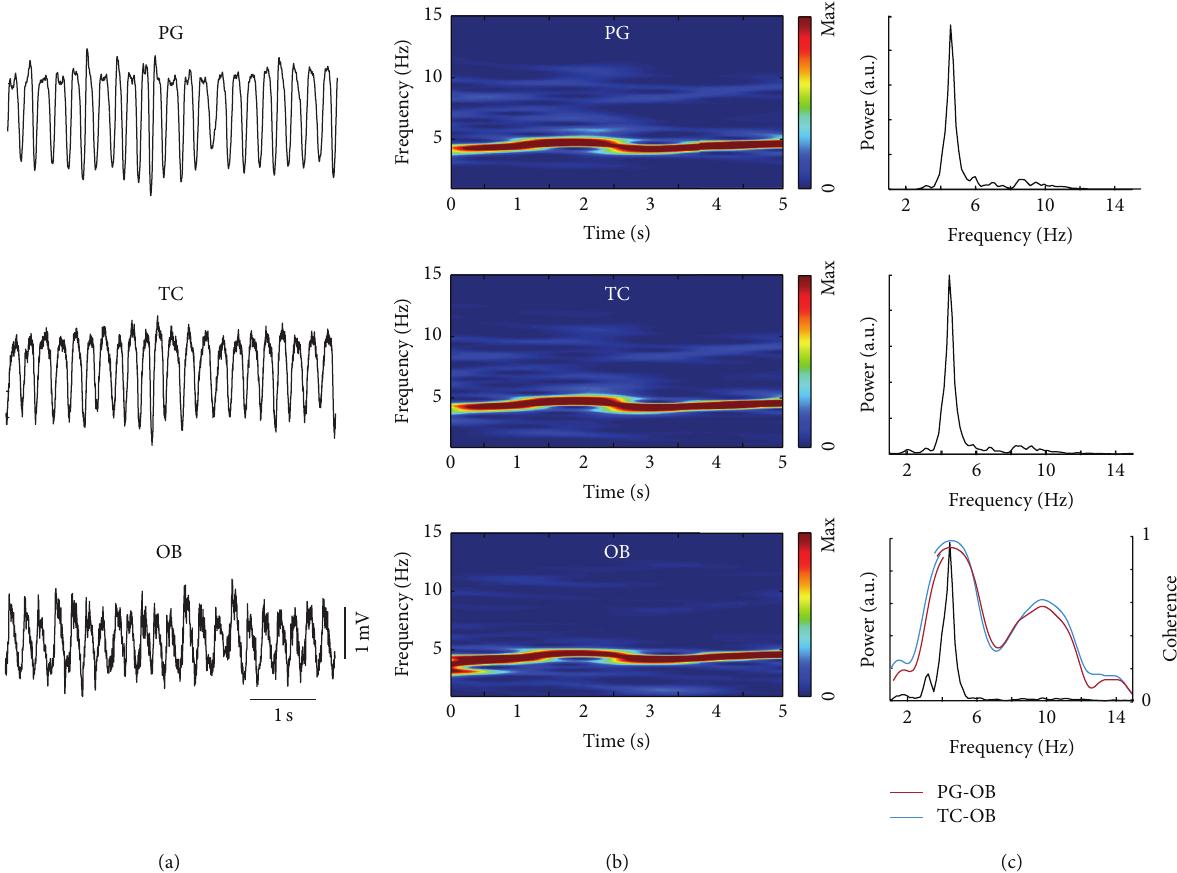
Figure 2: Plethysmography, nasal thermocouple, and olfactory bulb local field potentials similarly represent respiration during immobile waking. (a) Raw signals. (b) Time-frequency distribution. (c) Power spectral densities (black) and coherence (magenta: plethysmography (PG) versus olfactory bulb (OB), blue: thermocouple (TC) versus OB).